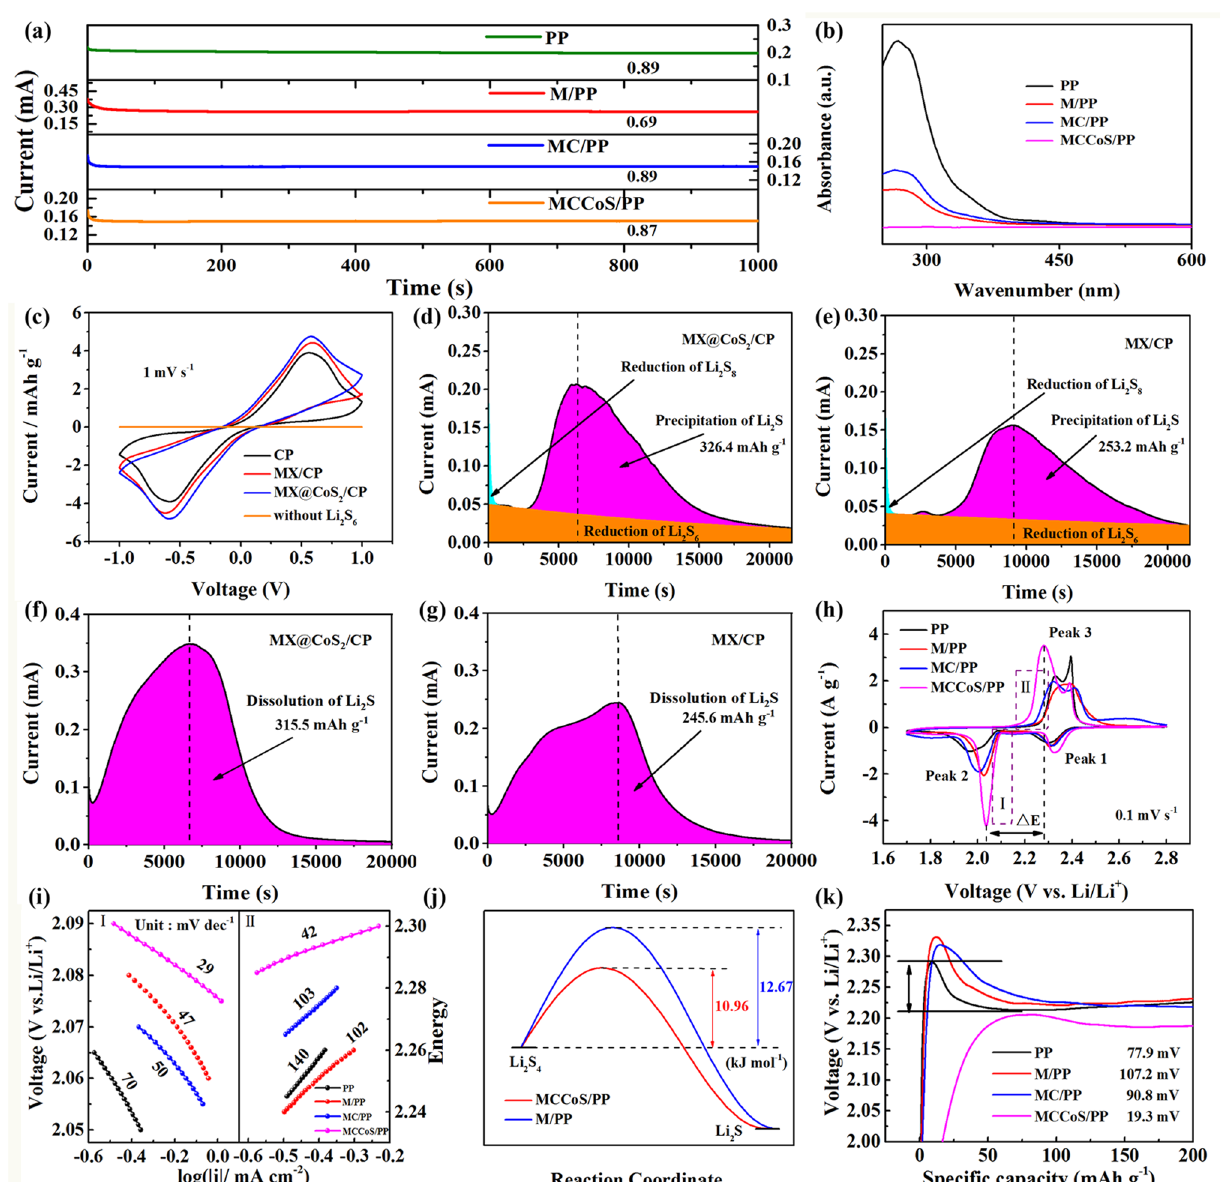
Fig. 3 a Lithium-ion transference numbers for the PP, M/PP, MC/PP and MCCoS/PP separators tested by Li || Li symmetric cells. b UV–vis absorption spectra of the liquid in the right of electrolyzer. c CV curves of the symmetric cells assembled using CP, MX/CP, and MX@CoS 2 /CP. Precipitation profiles of Li 2 S with d MX@CoS 2 and e MX. Dissolution profiles of Li 2 S with f MX@CoS 2 and g MX. h CV curves. i Tafel plots calculated from the Peak 2 and Peak 3 of CV curves. j Activation energies ( E a) of the Li 2 S 4 reduction. k Charge curves of Li–S battery based on the different